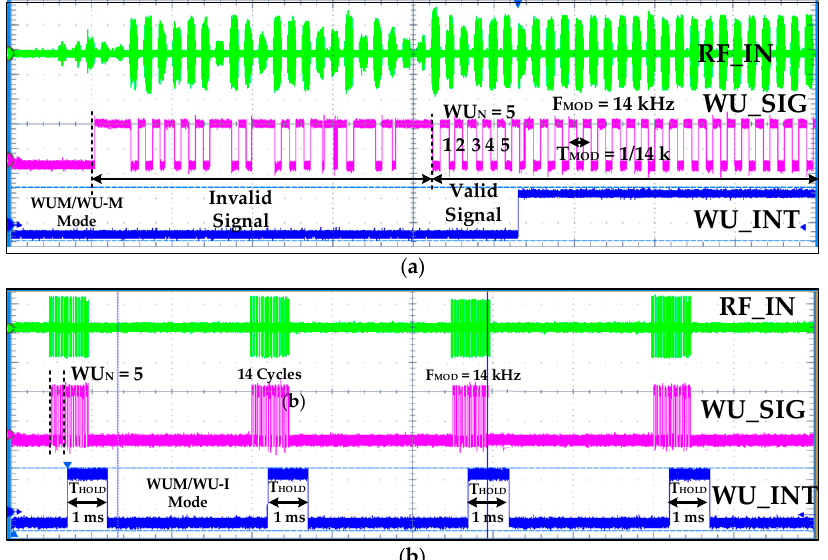
Figure 15. WuRx measurement result: ( a ) initially, invalid random sequence and then valid wake-up signal; ( b ) wake-up valid signal burst for robustness testing.